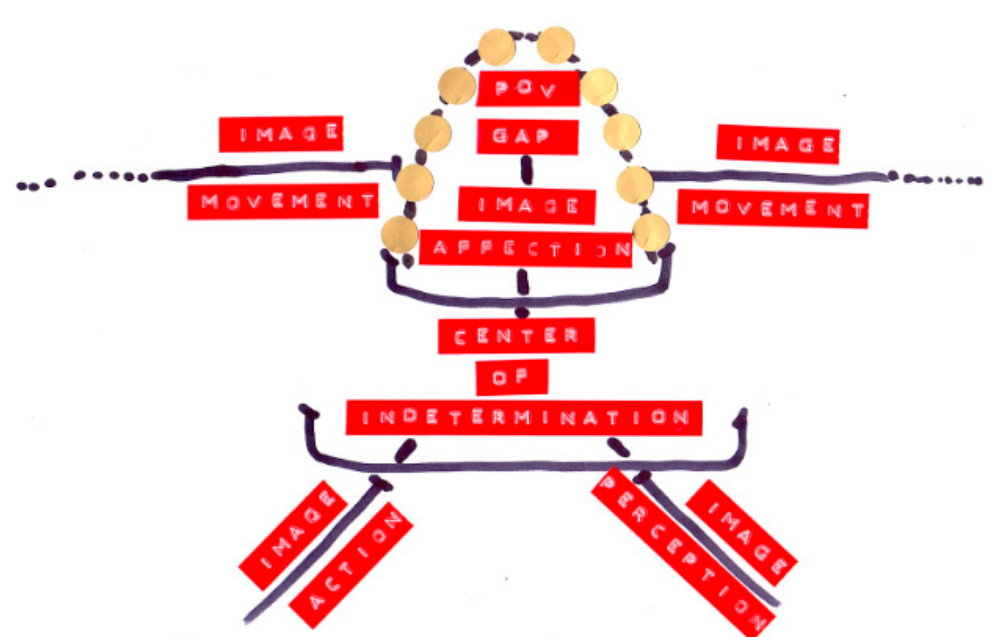
Figure 1. From movement-image to center of indetermination, affect-image, perception-image,